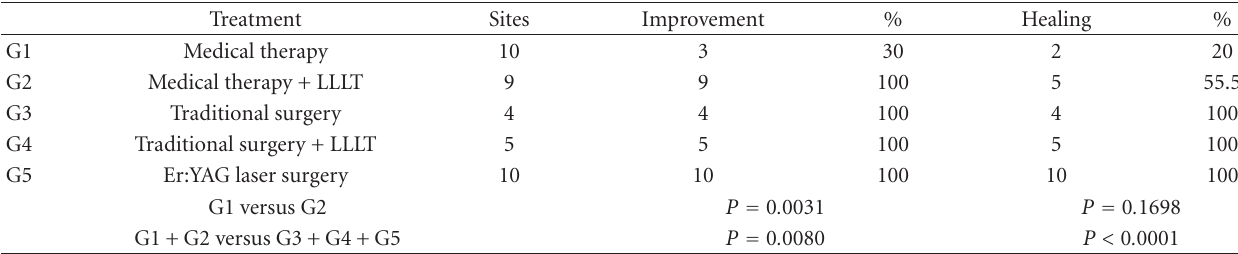
Table 4: Clinical results and statistical analysis in noncancer patients in terms of clinical improvement and complete healing. Statistical analysis in cancer patients: comparison between nonsurgical nonlaser-assisted approach (G1) and nonsurgical laser-assisted approach (G2) and comparison between nonsurgical approach (G1 + G2) and surgical approach (G3 + G4 + G5).